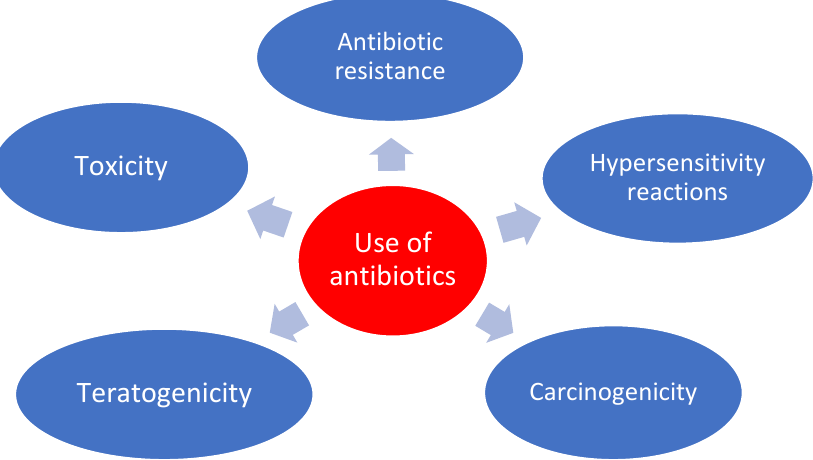
Figure 3. Effects of antibiotics use on human health.